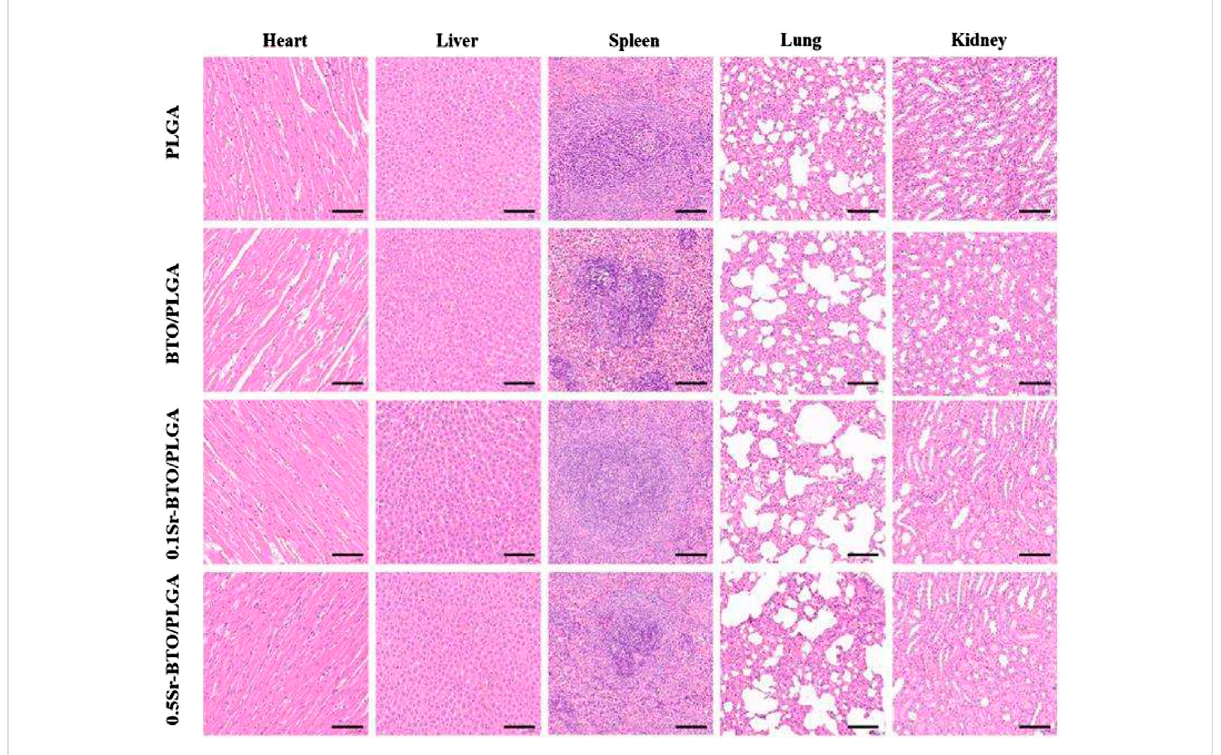
FIGURE 11 Biological assessment of lung, liver, spleen, kidney, and heart. The scale bar is 100 μ